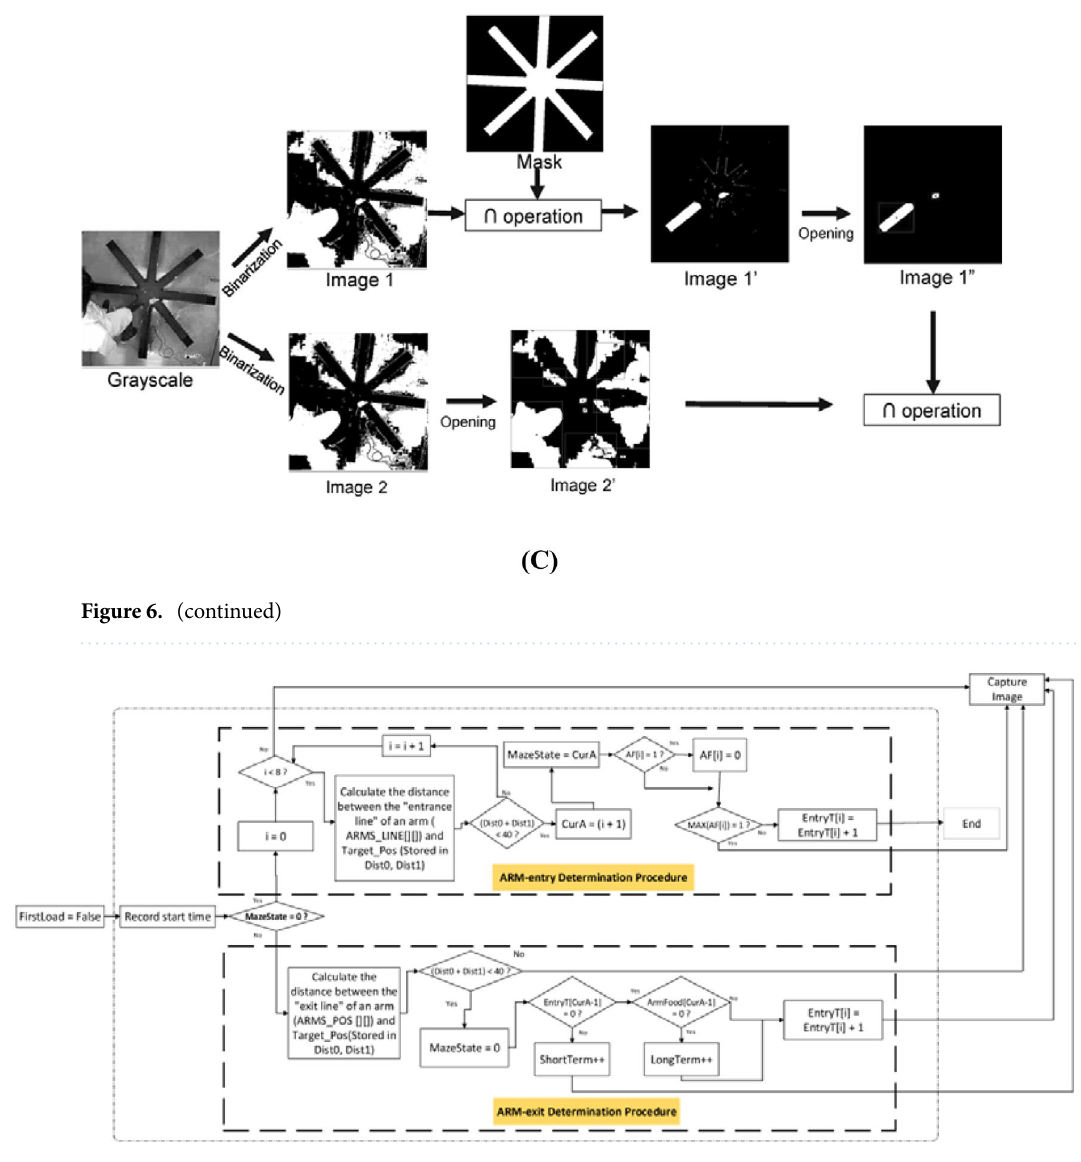
Figure 7. An “access to arms” monitoring